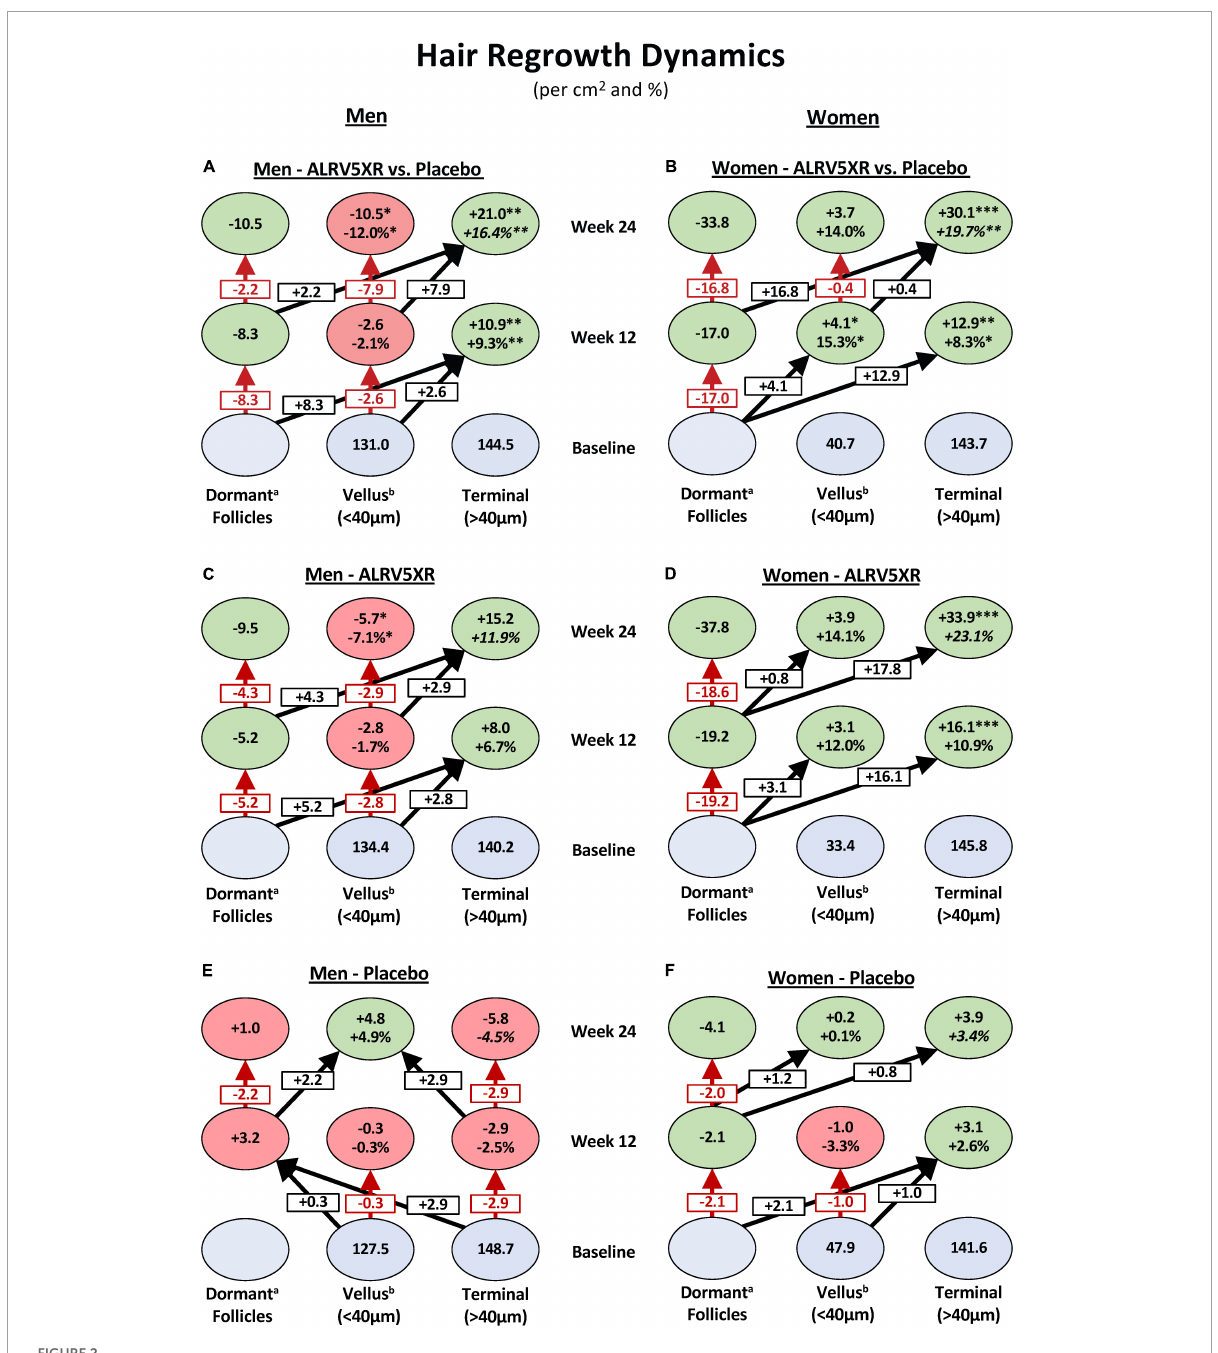
FIGURE2 Hair regrowth dynamics of ALRV5XR vs. placebo in women and men with AGA and TE over 24 weeks. ALRV5XR vs. Placebo (A,B) , ALRV5XR (C,D) , placebo (E,F) . The dynamics show for women, new hair growth is primarily from dormant hair follicles, and in men, terminal hair is mostly regenerated via miniaturization reversal of vellus-like hair. Baseline values in blue ovals are absolute counts of vellus and terminal hair. Values at 12 and 24 weeks are absolute and relative changes in hair counts from baseline. Decreases in dormant follicles represent the total of new hairs grown. Vellus hair includes true vellus, vellus-like, and new hair. Dormant follicle changes are the sum of vellus and terminal hair changes, and any small differences in these results compared to total hair density changes are due to rounding or methods of analyzing evaluable subjects for total hair density. Dormant follicle counts at baseline are not known. Values at 12 and 24 weeks are absolute and relative changes in hair counts from baseline. For vellus and terminal hairs, green ovals represent increases in hair, and red ovals represent decreases. Decreases in dormant follicles are colored green. a: Changes in dormant follicles account for less empty follicles due to new hair regrowth. b: Vellus Hairs include True Vellus, Vellus-Like, and New Hairs. Arrows in black show new hairs from dormant follicles regrowing into vellus or terminal hairs and vellus hairs thickening into terminal hairs. Arrows in red are reductions in vellus hairs or dormant follicles. Statistical significance between ALRV5XR and placebo: ∗ p < 0.05; ∗∗ p < 0.01; ∗∗∗ p <